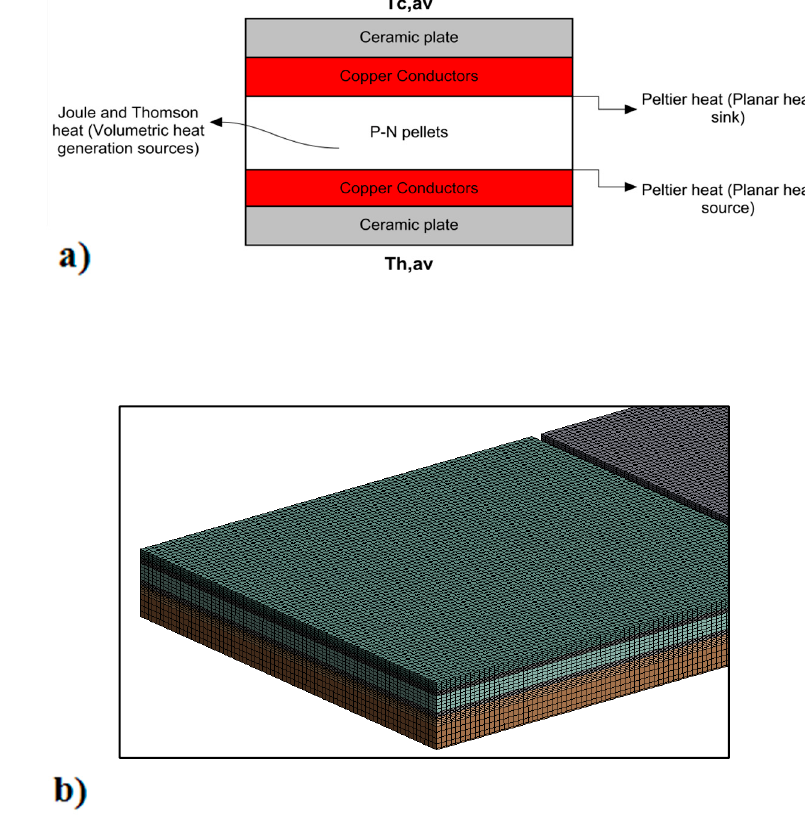
Figure 4. ( a ) Schematic diagram of numerical model and ( b ) computational grid of the TEG module.